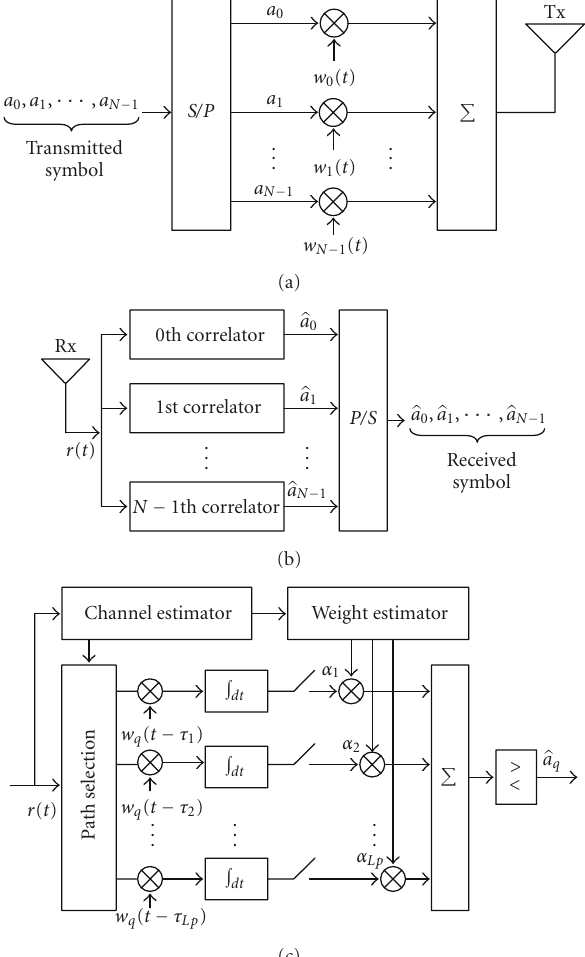
Figure 5: (a) A simple transmitter structure for N -bit OOK-PSM scheme. (b) Receiver structure for combined N -bit OOK-PSM scheme. (c) RAKE receiver structure for q th( q = 0,1, ... , N − 1)